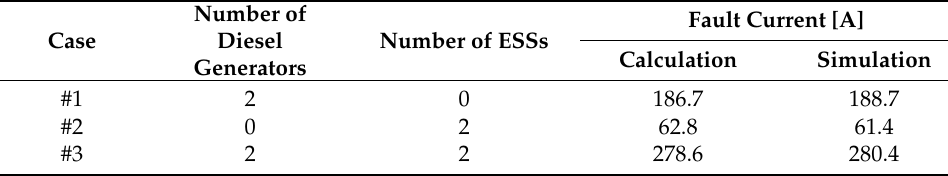
Table 7. Summary of fault current calculation and simulation.